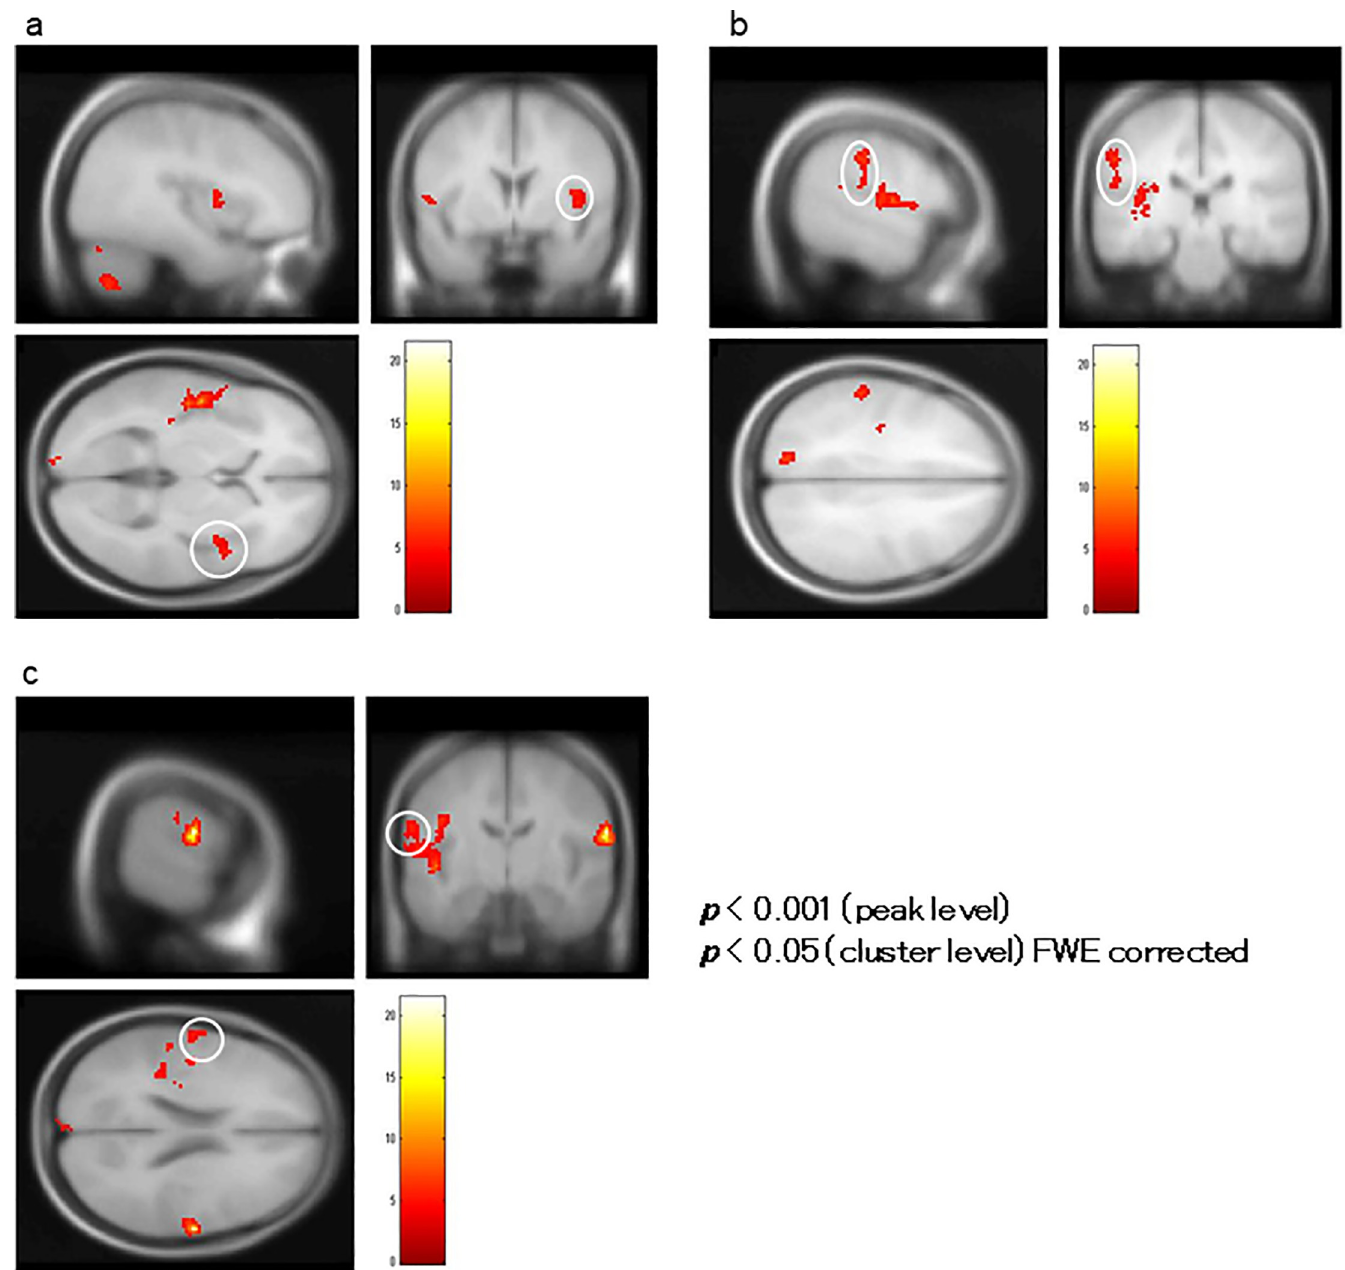
Fig 10. Correlation analysis of BOLD signal changes in the left Heschl’s Gyrus (HSC). In a correlation analysis using blood oxygenation level-dependent (BOLD) signal change (%) in the HSC as a covariate in ROI analysis, BOLD activity in the left insula encompassing the superior temporal gyrus (not shown), right insula (indicated by the white circle in (a)), right postcentral gyrus (indicated by the white circle in (b)), and left inferior parietal lobule (indicated by the white circle in (c)) significantly correlated with BOLD signal changes in the left HSC.